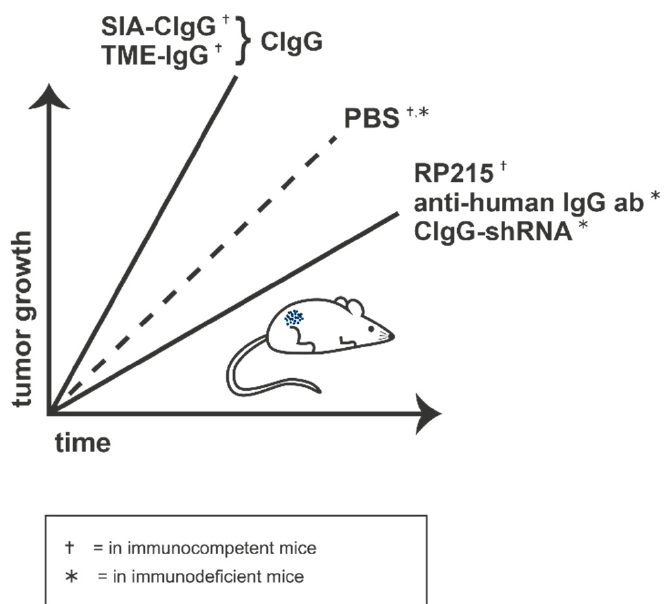
Figure 3. The protumoral effect of SIA-CIgG and TME-IgG causes an accelerated tumor outgrowth in vivo. Treatment with RP215, anti-human IgG antibody, or CIgG-shRNA, in contrast, reduces tumor growth rates in vivo. ab: antibody, PBS: phosphate buffered saline, CIgG: cancer-derived IgG, SIA-CIgG: sialylated CIgG, TME-IgG: IgG isolated from tumor microenvironment. The above-listed findings all revolve around effects on the tumor cells themselves.